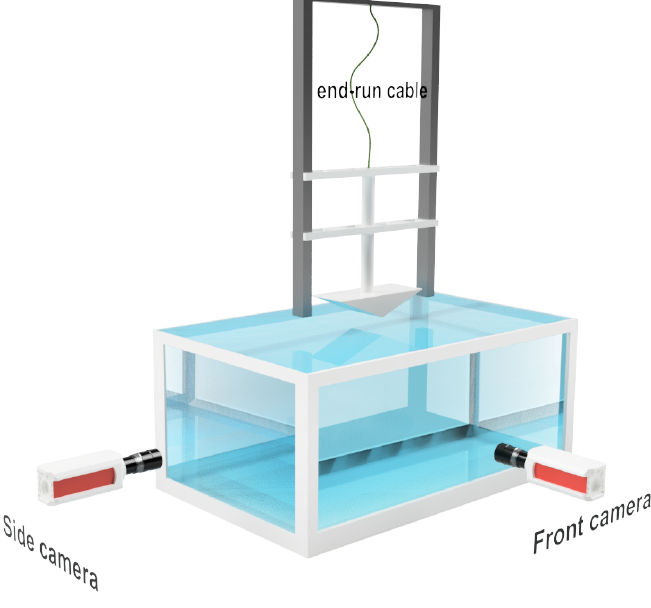
Figure 4. Schematics of a water-entry apparatus. The two possible locations (side and front) of the camera are showed. The sketch highlights the end-run cable used to stop the motion.